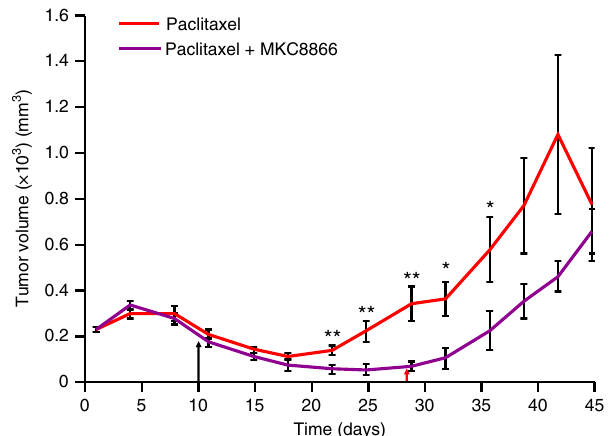
Fig. 8 MKC8866 reduces tumor regrowth post-paclitaxel withdrawal. Xenografts were established by subcutaneously injecting 5 × 10 6 MDA-MB- 231 cells into the right fl ank of female athymic nude mice (Crl:NU(Ncr)- Foxn1nu , Charles River). When tumors were palpable (250 mm 3 ) mice were randomized into groups and treatments initiated. Paclitaxel (7.5 mg kg − 1 by intravenous injection) was administered every second day until day 10 (last dose indicated by the black arrow) as a single agent or in combination with MKC8866 (300 mg kg − 1 by oral gavage). MKC8866 treatment was administered daily from day 1 to 28 (last dose indicated by the red arrow). Tumor size was assessed every 2 – 3 days via caliper measurement and tumor volume calculated ( n = 10 mice per group). * P < 0.05, ** P < 0.01 based on a Student ’ s t test. Error bars represent